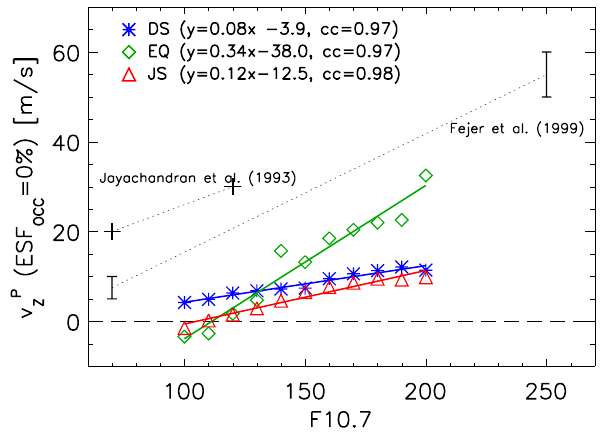
Fig. 5. The threshold v P z plotted versus the solar activity index, F10.7 for different seasons. Results based on radar observations are also included and linked by a dotted line for better visualisation.